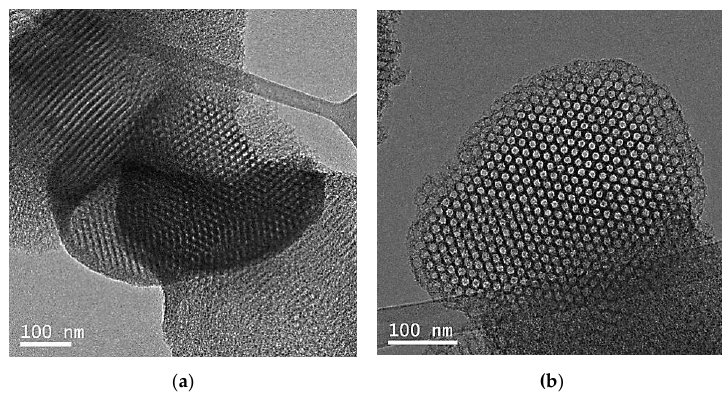
Figure 4. TEM images of: ( a ) E-SBA-S and (b) Ti-E-SBA-S materials.